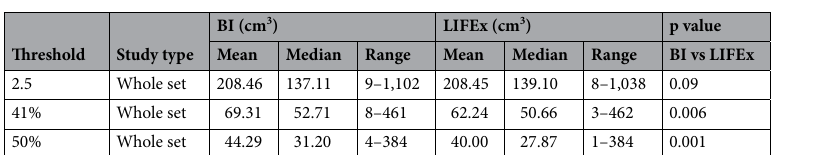
Figure 2. Bland Altman analysis for TMTV obtained using different thresholds. Comparison between software tools BI versus LIFEx. SUV > 2.5 threshold delimitation ( A ), SUV > 41% SUVmax ( B ) and SUV > 50% SUVmax ( C ). Values outside the agreement region in dashed grey lines were marked as black cross outliers but were not discarded from the analysis.